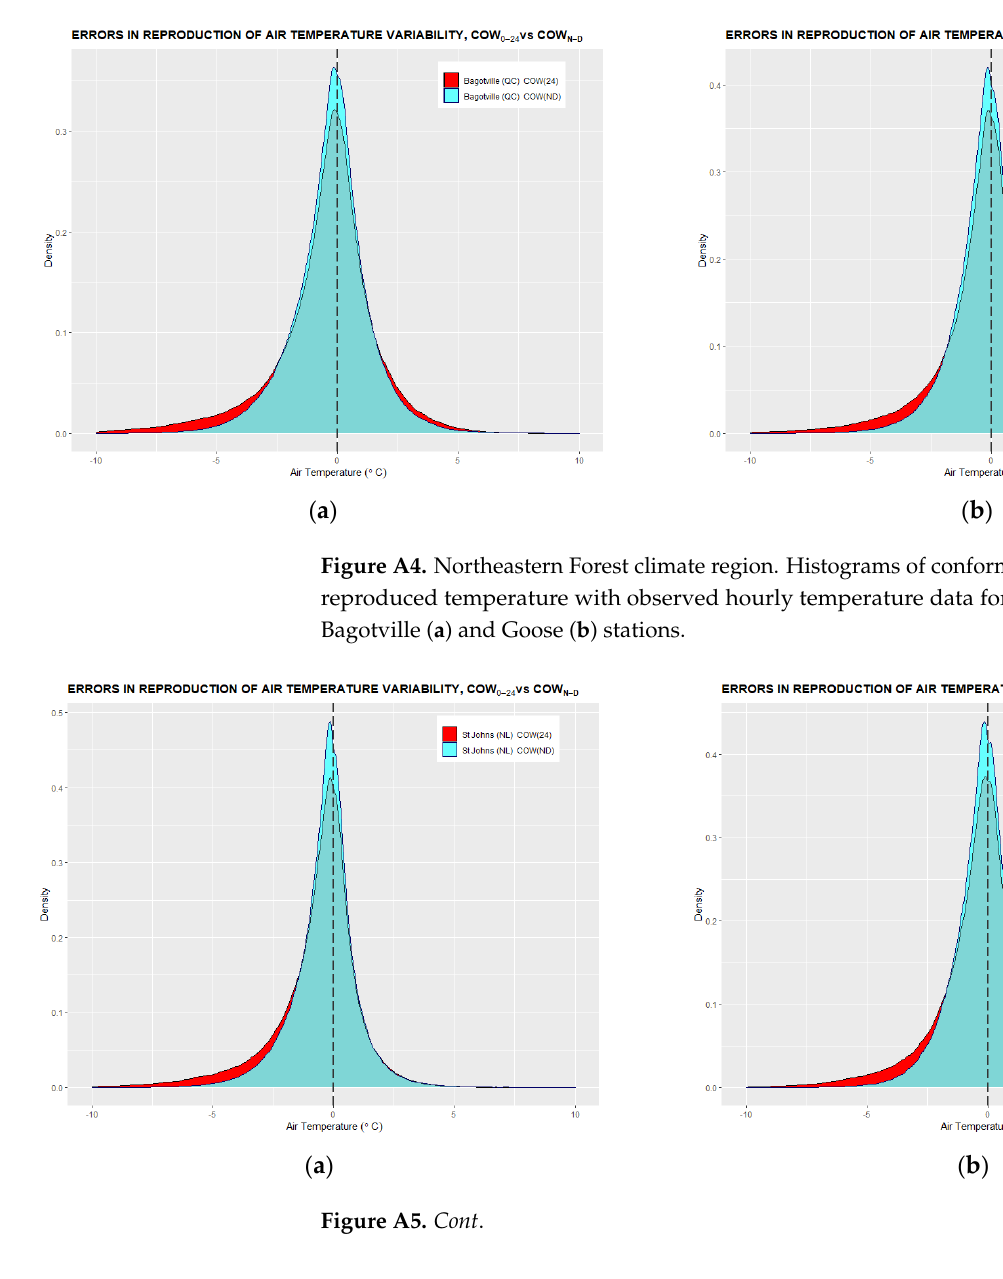
Figure A3. Prairies climate region. Histograms of conformity of COW 0–24 and COW N–D reproduced temperature with observed hourly temperature data for the 1953–2018 data period at Calgary ( a ), Saskatoon ( b ), Winnipeg ( c ), and Estevan ( d ) stations .